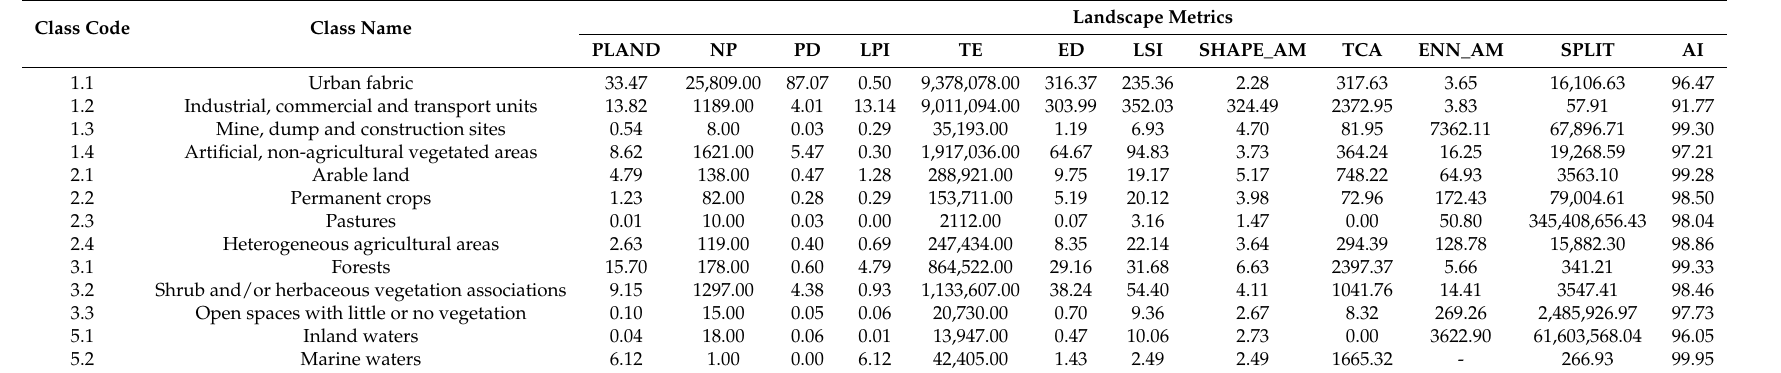
Table 10. Level 2 landscape metrics results.